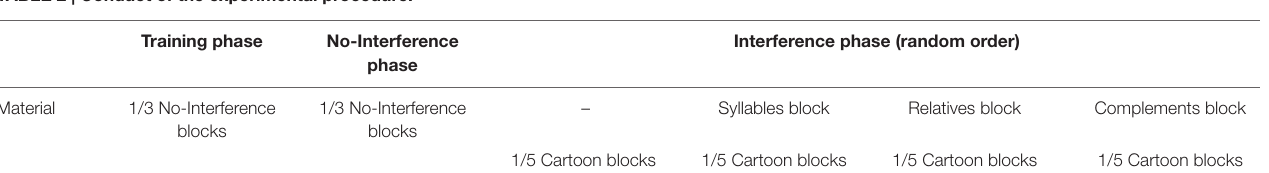
TABLE 2 | Conduct of the experimental